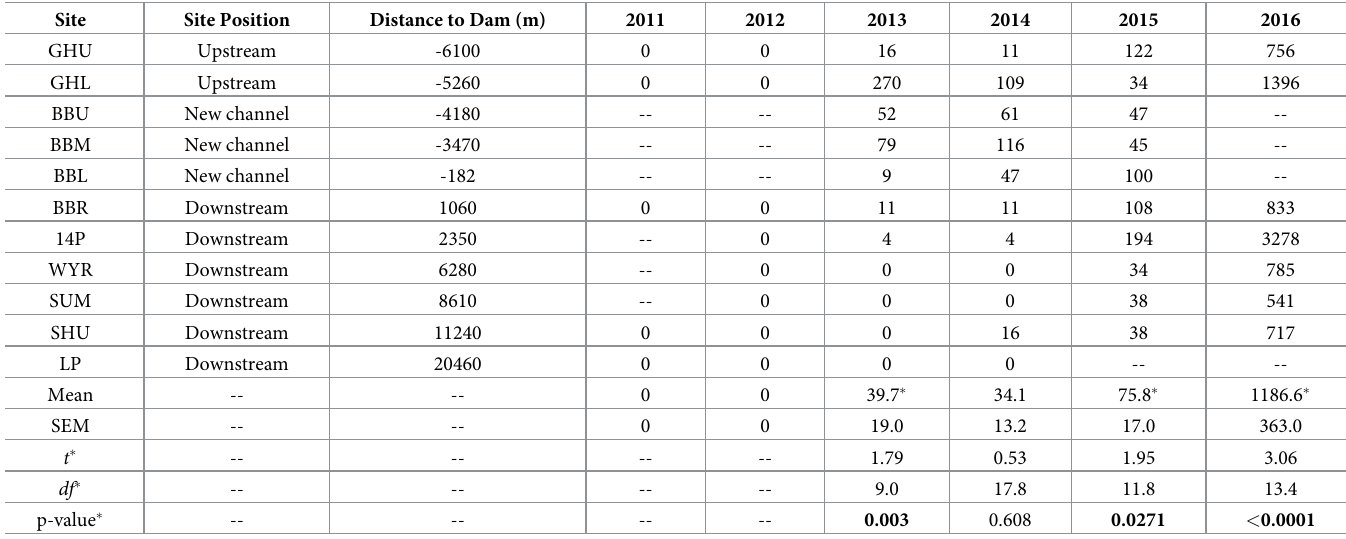
Table 5. Density (individuals/m 2 ) of New Zealand mud snails ( Potamopyrgus antipodarum -Hydrobiidae) from 2011–2016, Boardman River, Michigan